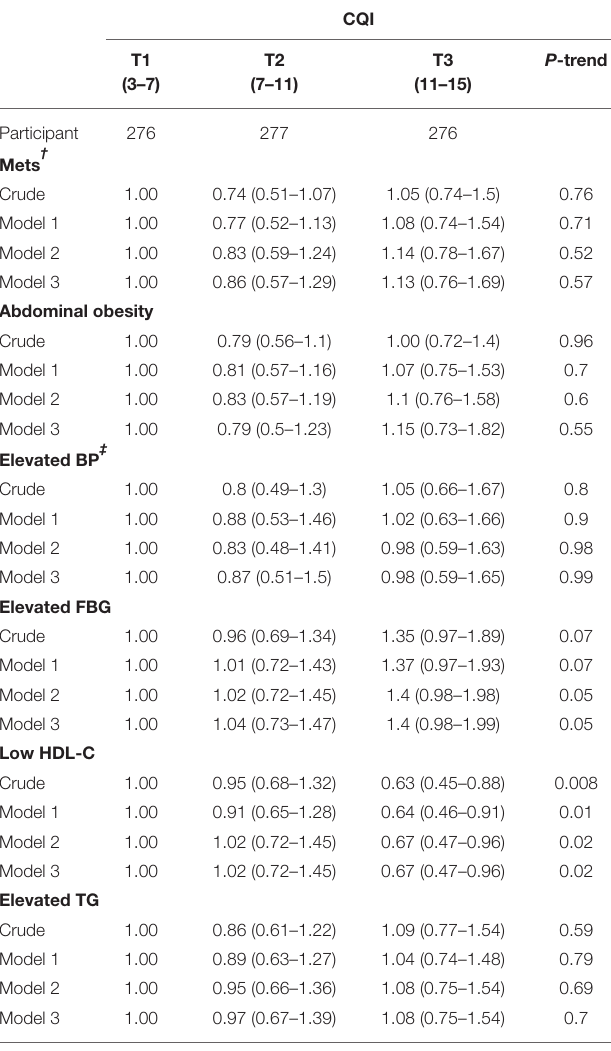
TABLE 3 | Odds ratio (OR) and 95% CI for metabolic syndrome and components among the study participants according to tertiles (T) of CQI in habitual